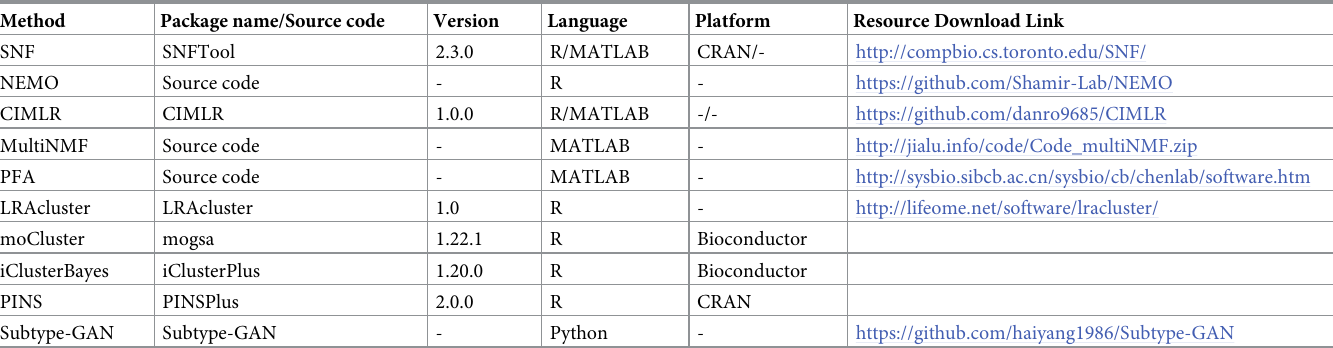
Table 2. Details of packages or codes used in this